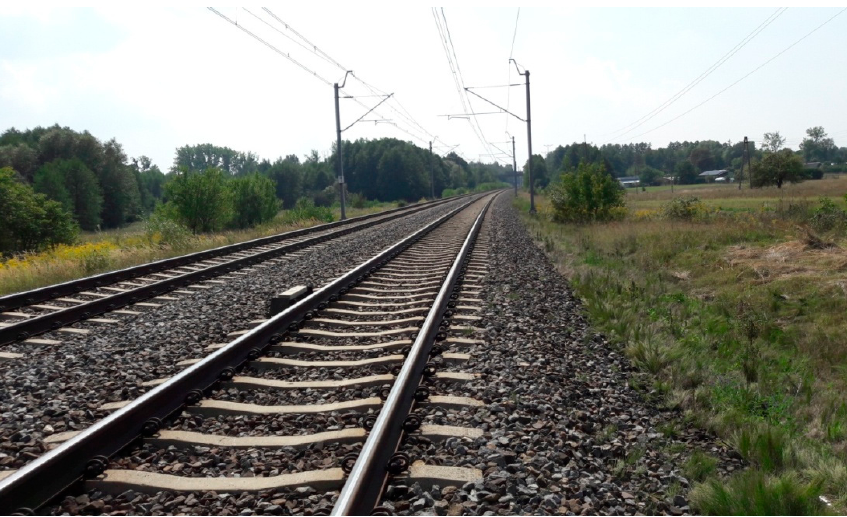
Figure 4. Railway track at km 18 + 600—experimental research area